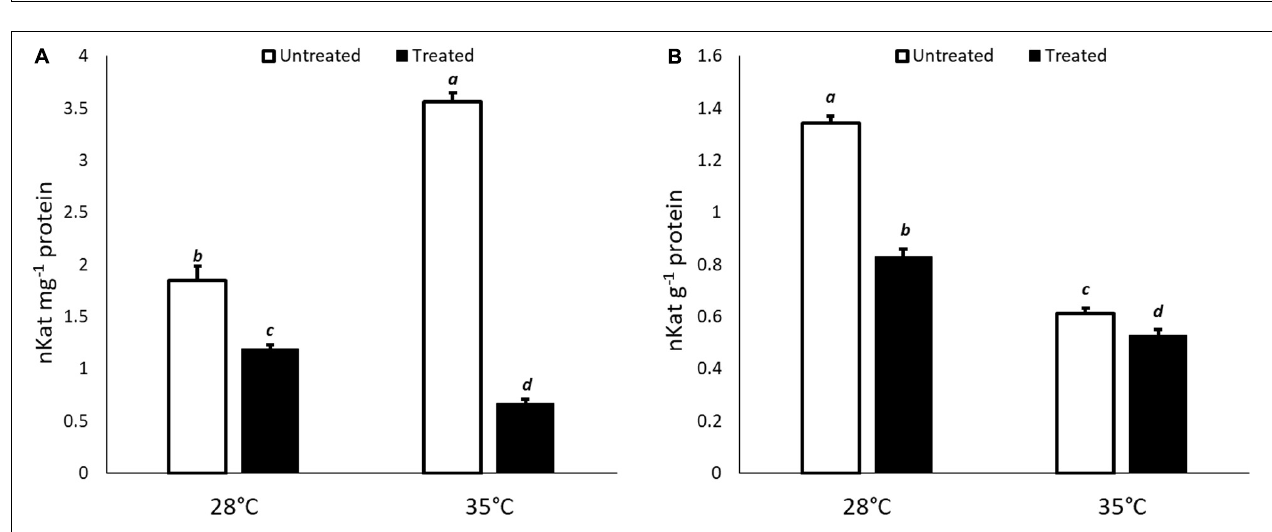
FIGURE 3 | Effect of KIEM R (cid:13) on ICL expression levels at 24 (A) and 48 h (B) after seed incubation. Values are expressed as a relative gene expression obtained by comparing KIEM R (cid:13) -treated samples with the corresponding untreated controls (dotted line). Bars represent the mean ± SD of three biological replicates. For each bar, different lowercase letters indicate significant differences ( p ≤ 0.05) between treatments with the biostimulant at the two different temperatures (28 and 35 ◦ C), as measured by one-way ANOVA followed by Tukey’s post hoc test. Asterisks (*) indicate significant differences ( p ≤ 0.05) between KIEM R (cid:13) -treated samples and the correspective untreated control at the same temperature condition, as measured by t -test.